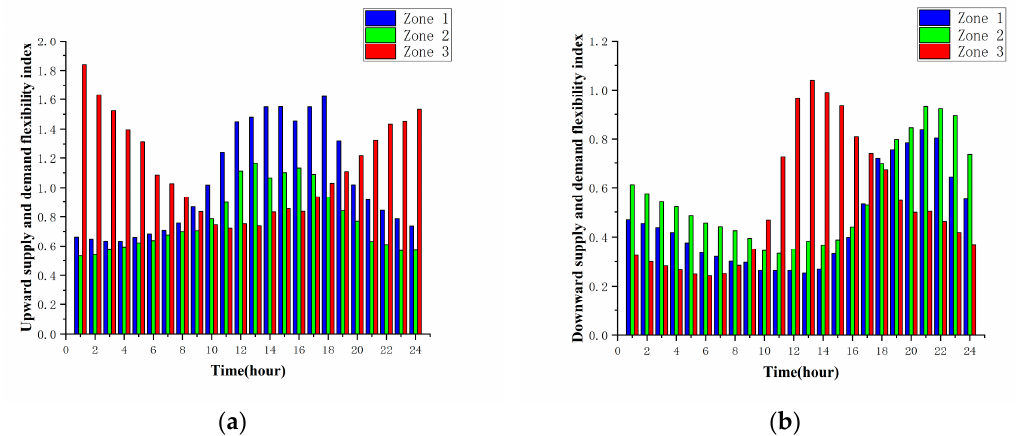
Figure 9. Supply and demand flexibility index of each zone. ( a ) upward. ( b )